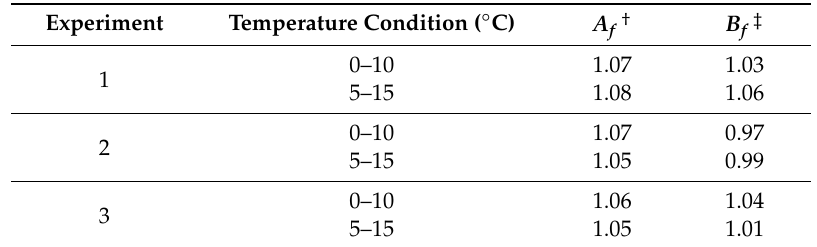
Table 5. Comparison of accuracy and bias factors of the predictive models using the assumption N max = N max ( T ) for experiments 1 to 3.